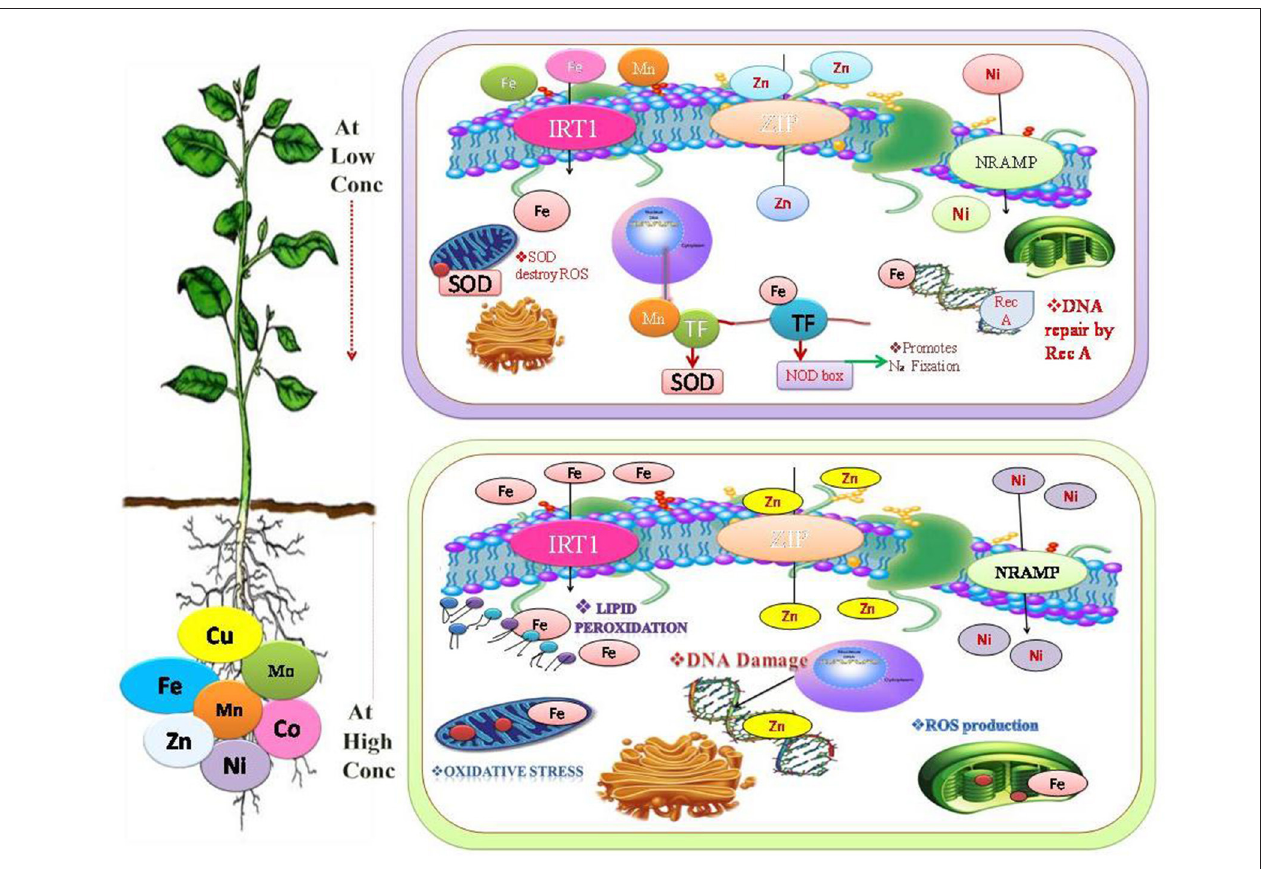
FIGURE 1 | Beneficial heavy metals are play a significant role at low concentration in the synthesis of protein, nucleic acids, photosynthetic pigment, and it also involved in the structural and functional integrity of cell membranes ( Oves et al., 2016). Mn promotes antioxidant activity (Shenker et al., 2004), Fe promotes N 2 -Fixation and DNA repair (Møller et al., 2007). While at high fconcentration it cause substitution of many essential functional groups, for instance, lipid peroxidation (LPO), cellular damage, generation of reactive oxygen species (ROS), disturbance in the various metabolic reaction by altering the enzymatic activity ( de Oliveira Jucoski et al., 2013; Anjum et al., 2015